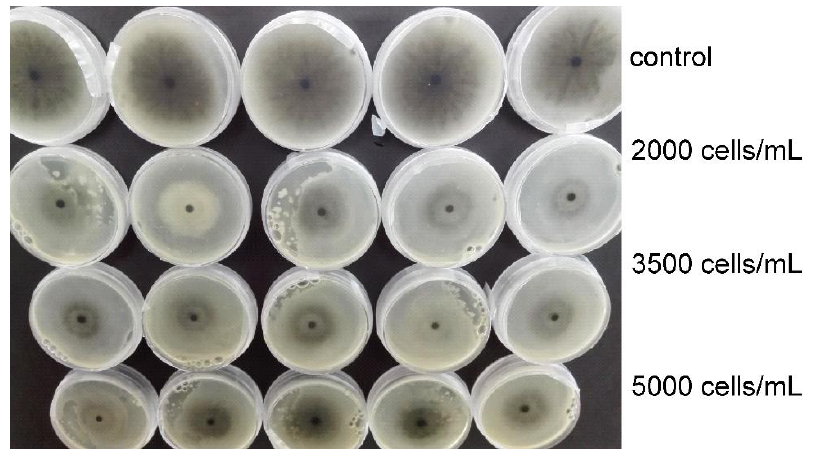
Figure 5. Petri dishes with Macrophomina phaseolina mycelium 72 h after treatment with Allolobophora chlorotica coelomic fluid extract.